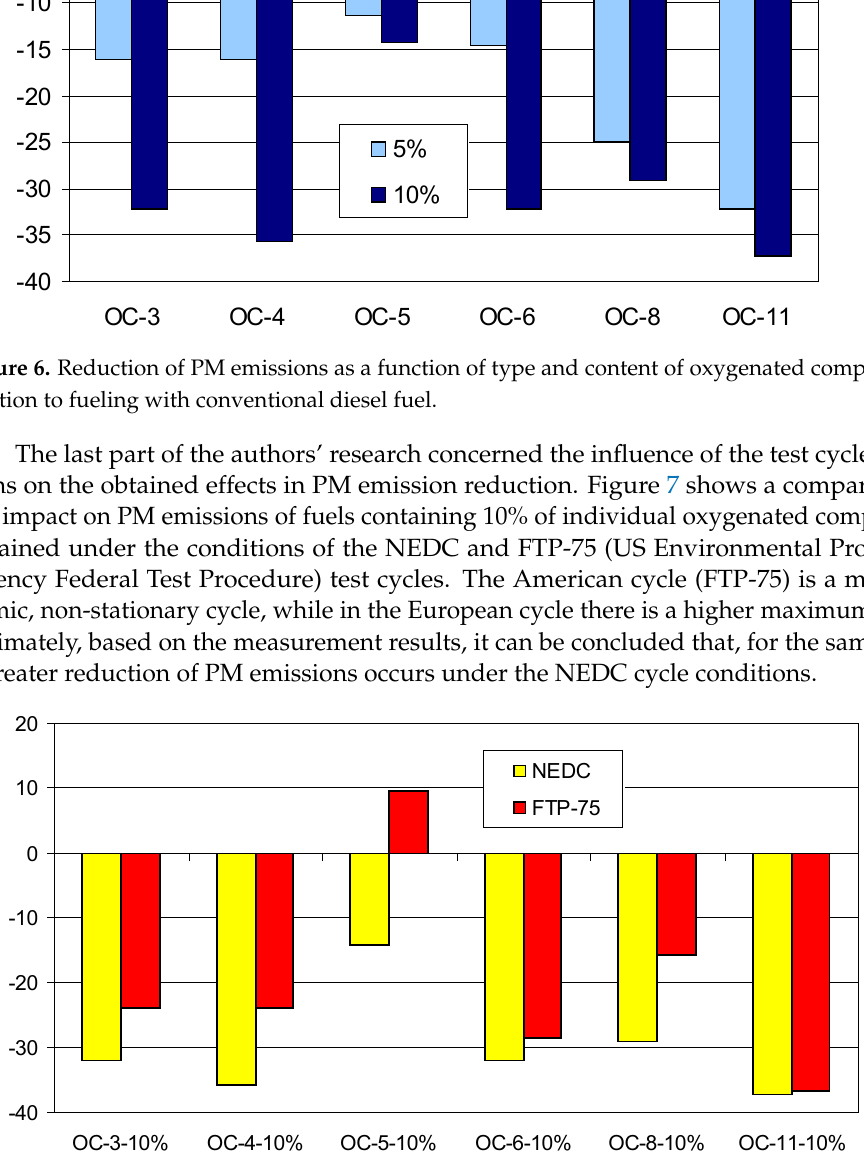
increasing oxygenates’ content brings beneficial results, albeit to a different extent. For glycol ethers, doubling the fuel content also doubled the decrease in PM emissions. For maleate and carbonate, the benefit of increasing content was significantly smaller. It can be Figure 5. Unit effect of oxygenate and oxygen content in fuel on PM emissions over the NEDC from seen that at the 10% content, there are no significant differences in reducing PM emissions for glycol ethers and carbonates that were so characteristic at the lower content (5%). Thus, a test car with fuels containing individual oxygenates at a concentration of 5% v / v compared to with a content of 10%, the effectiveness of the best components from all tested chemical running on conventional diesel fuel. groups was similar, i.e., PM reduction by 30–40%.